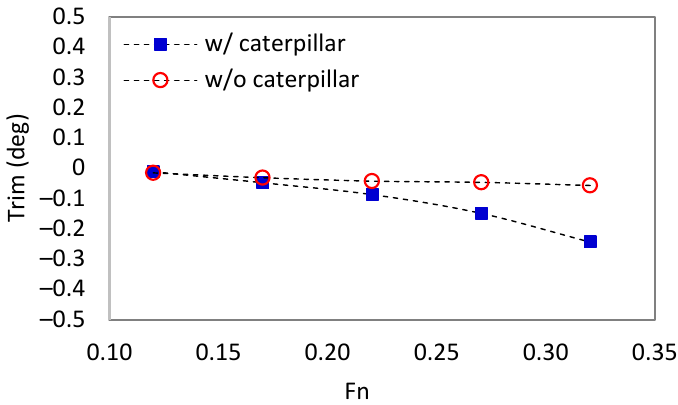
Figure 6. Trim for the vessels w/and w/o caterpillars.